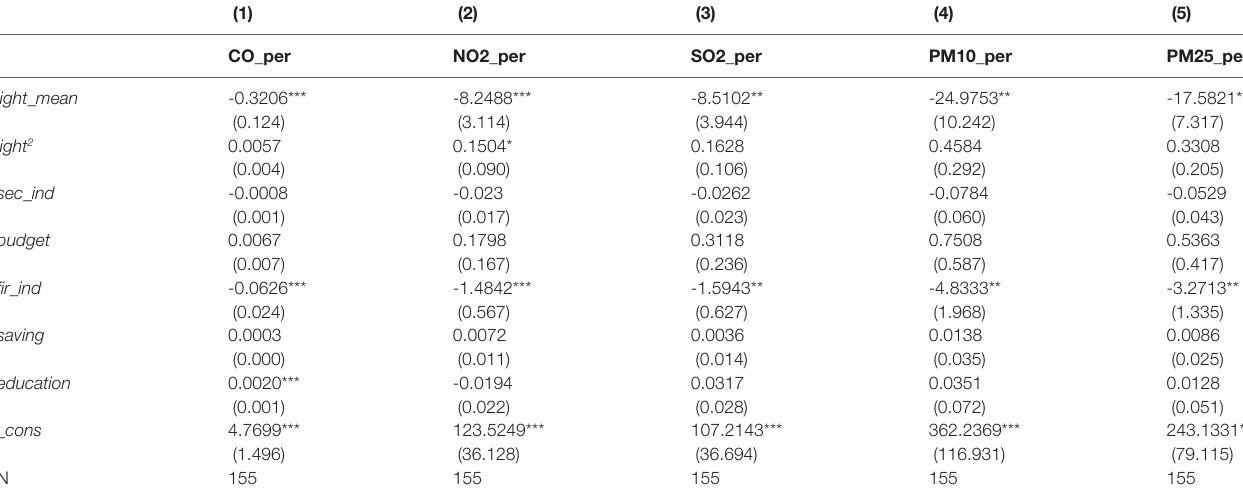
TABLE 7 | The impact of economic development on air pollutants intensity with the secondary term of night